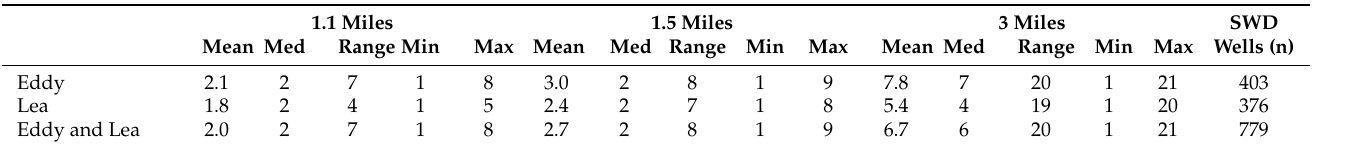
Table 5. Descriptive statistics of number of oil and gas wells within 1.1, 1.5, and 3-mile distances from SWD